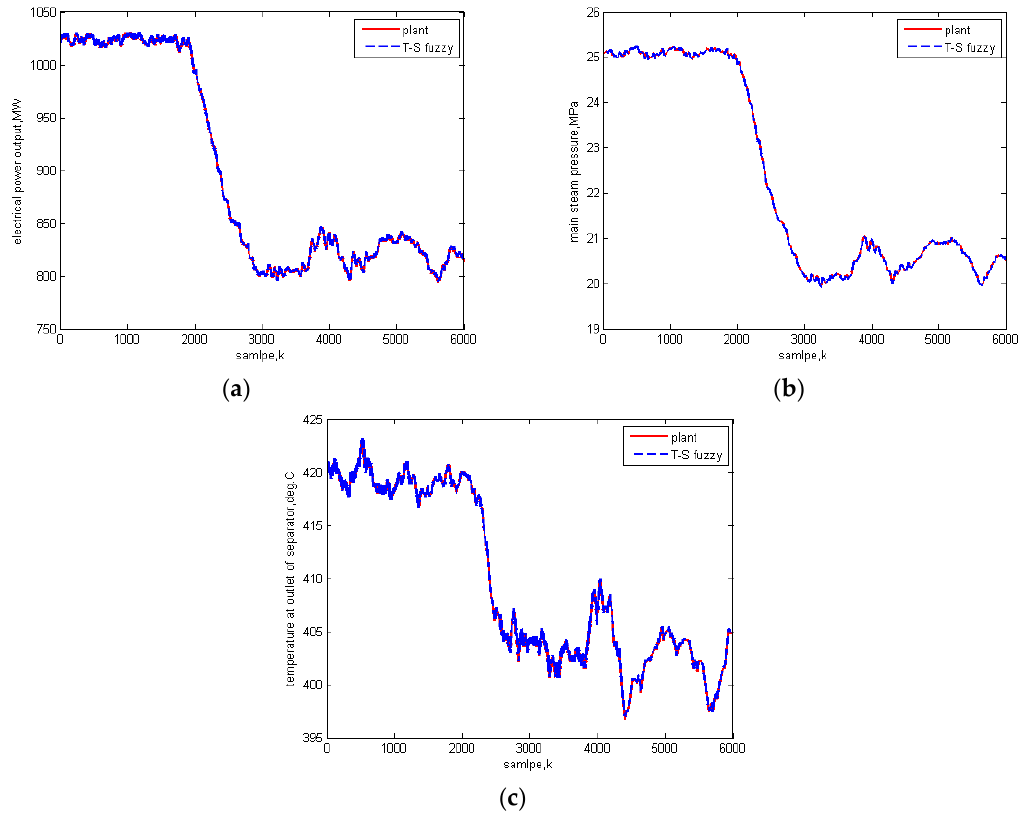
Figure 7. ( a ) Comparison of T ‐ S fuzzy model and new test data 2 for electrical power output; ( b ) Comparison of the T ‐ S fuzzy model and new test data 2 for main ‐ steam pressure; ( c ) Comparison of T ‐ S fuzzy model and new test data 2 for the separator outlet steam temperature.